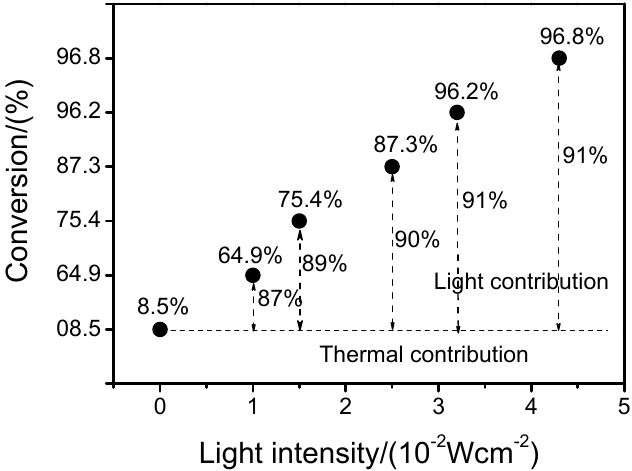
Figure 5. Effect of light intensity on the esterification of benzaldehyde using 71 wt% Ag 3 PO 4 /Ag/Bi 2 O 2 CO 3 .